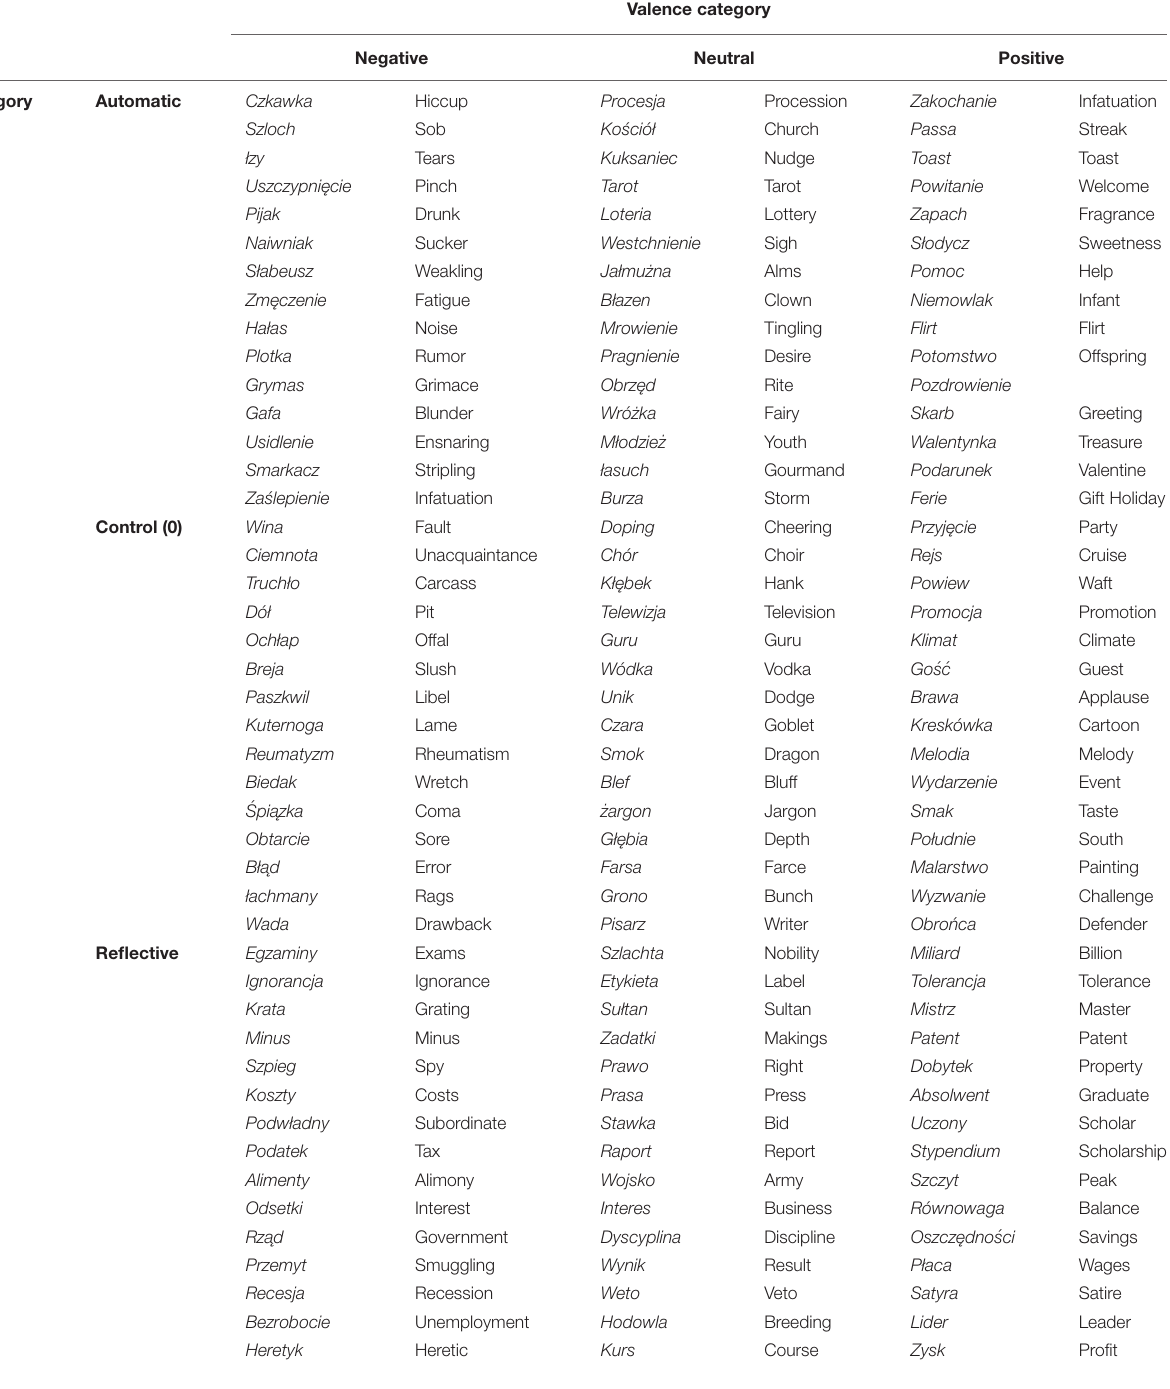
TABLE 3 | The full list of words stimuli used in each